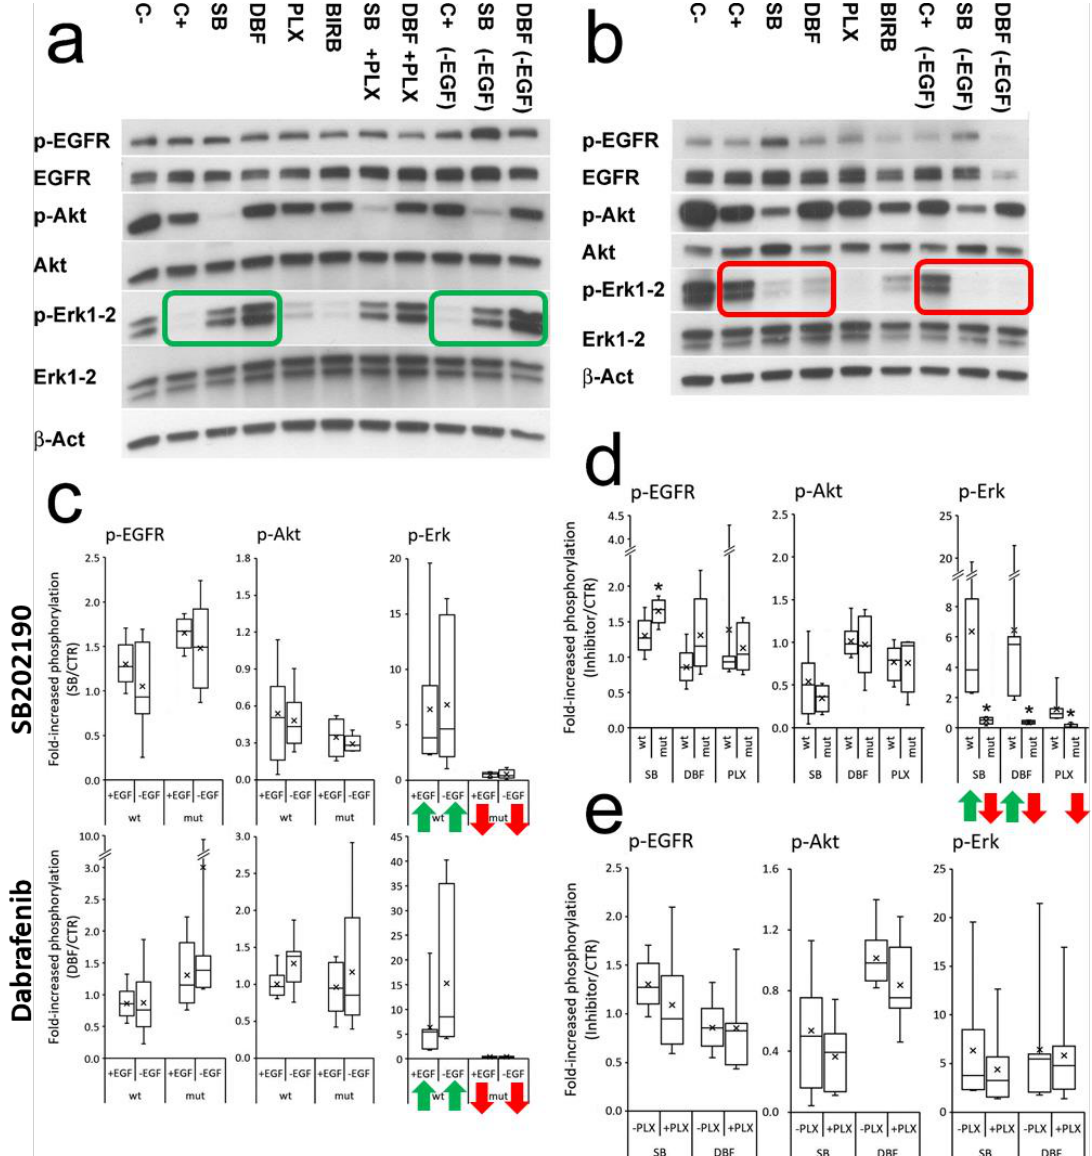
Figure 3. SB202190 mimics the biochemical activity of the BRAF inhibitor Dabrafenib on p-Erk1-2 modulation, unaffected by EGFR activation. ( a ) An example of the signaling of a BRAF wild-type organoid (OMCR18-035TK). The green rectangles highlight increased p-Erk1-2 activity induced by SB202190 and Dabrafenib, both in the presence ( left ) or absence ( right ) of EGF. ( b ) An example of the signaling of a BRAF mutated organoid (OMCR16-005TK, BRAF V600E). The red rectangles highlight the inhibition of p-Erk1-2 activity mediated by SB202190 and Dabrafenib, both in the presence ( left ) or absence ( right ) of EGF. Organoids were treated for 2 h in new culture medium with (C+) or without EGF (-EGF); 48 h old medium was used as control of basal activation (C − ). SB202190 (SB) 10 µ M, Dabrafenib (DBF) 1 µ M, PLX8394 (PLX) 1 µ M, BIRB796 (BIRB) 0.2 µ M. ( c ) The effect of EGF (25 ng/mL) on SB202190- or Dabrafenib-treated organoids is represented for p-EGFR, p-Akt and p-Erk1-2, according to BRAF wild-type or -mutant status. No condition achieved statistically significant difference. The green arrows indicate the powerful upregulation of p-Erk1-2 signaling induced by SB202190 and Dabrafenib in BRAF wt organoids as compared to its downregulation in the BRAF-mutated ones (red arrows). ( d ) Comparison of the effects of SB, DBF and PLX on p-EGFR, p-Akt and p-Erk1-2, in BRAF wild-type or -mutant organoids. ( e ) Effects of PLX+SB or PLX+DBF co-treatment in BRAF wild-type organoids. Statistics: * p ≤ 0.05 (wt versus mutant BRAF), n =